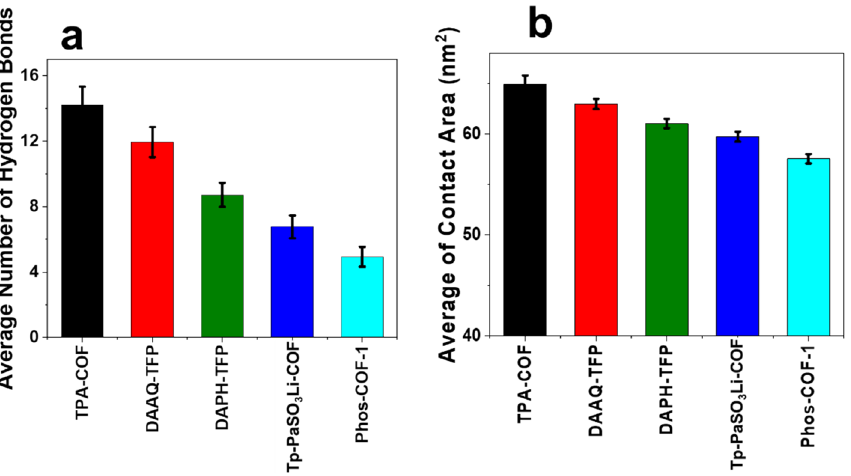
Figure 2. ( a ) Average number of hydrogen bonds between urea molecules and COFs Nanoparticles ( b ) Average of contact